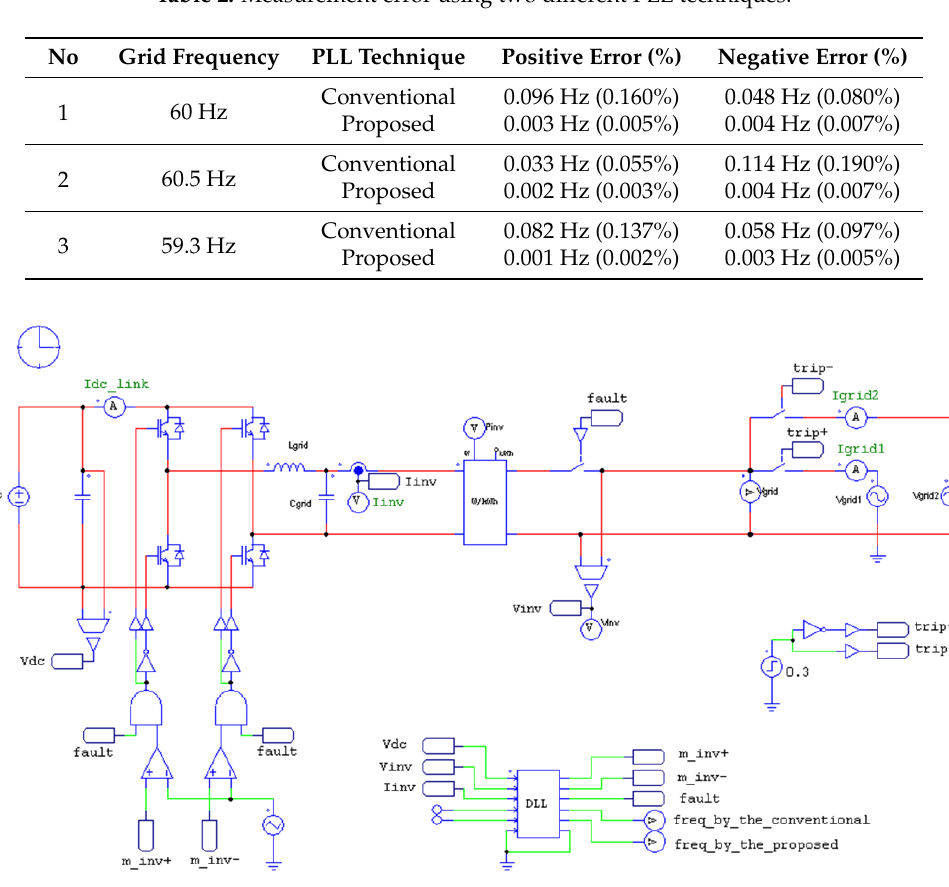
Figure 7. Simulation circuit of a single-phase PV micro-inverter for evaluating the grid-connection.